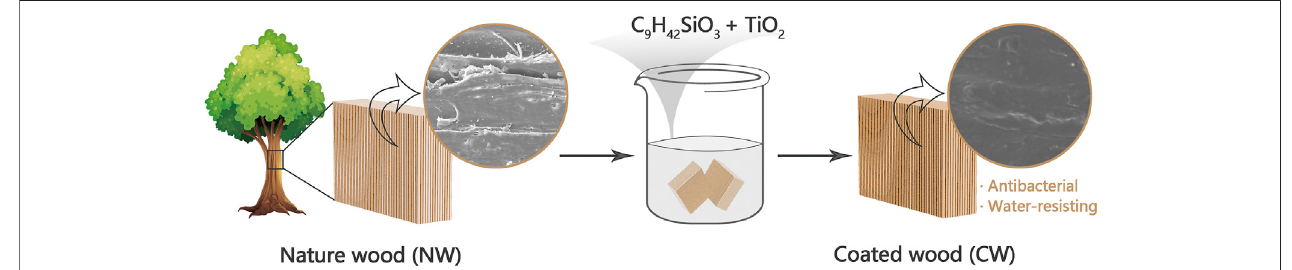
FIGURE 1 | Graphic illustration of the coated wood made from natural